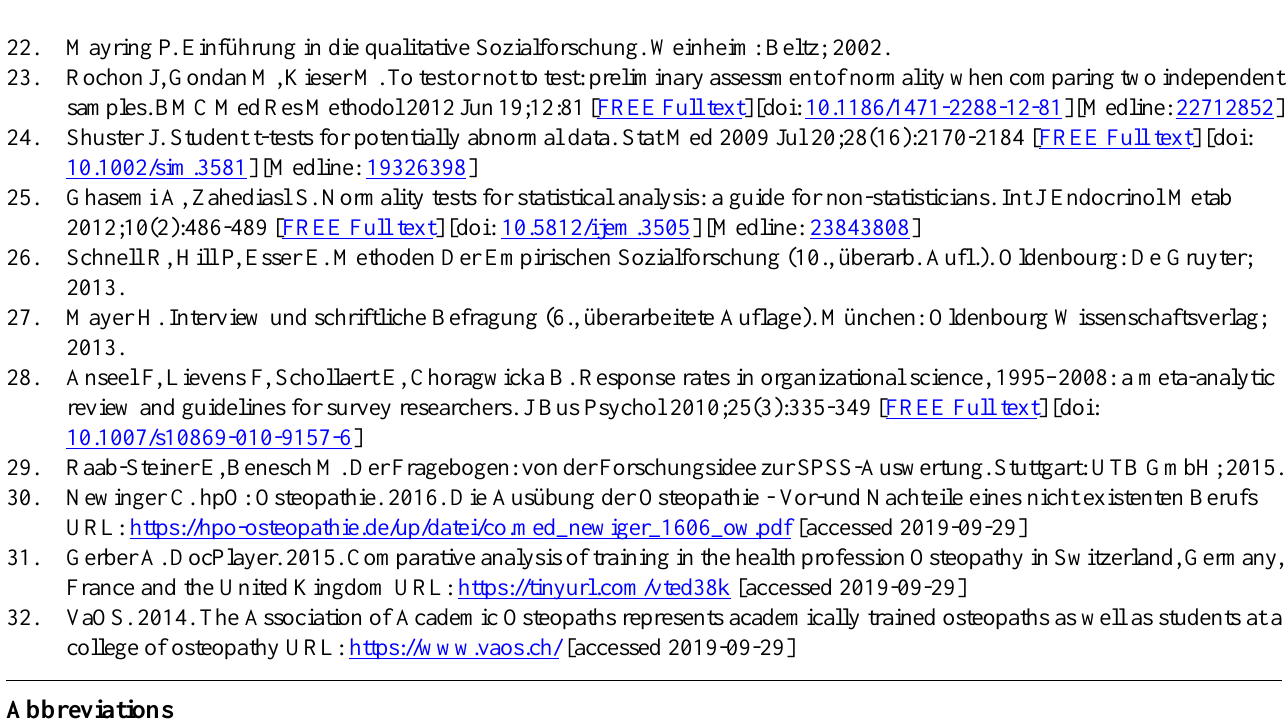
Abbreviations COCO: Characteristics, Opportunities, and Challenges of